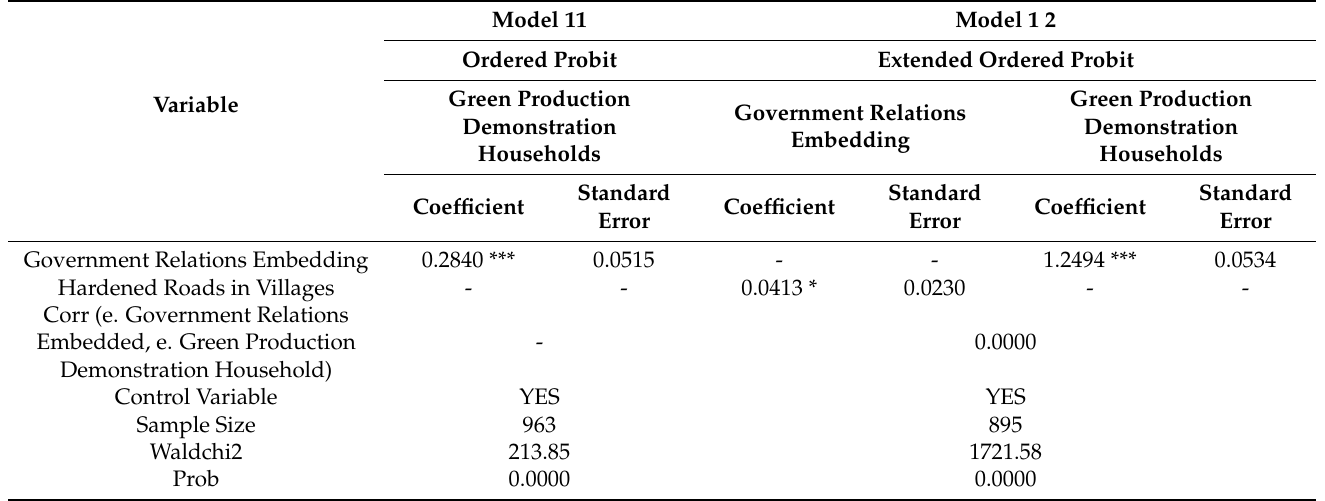
Table 6. Endogenous